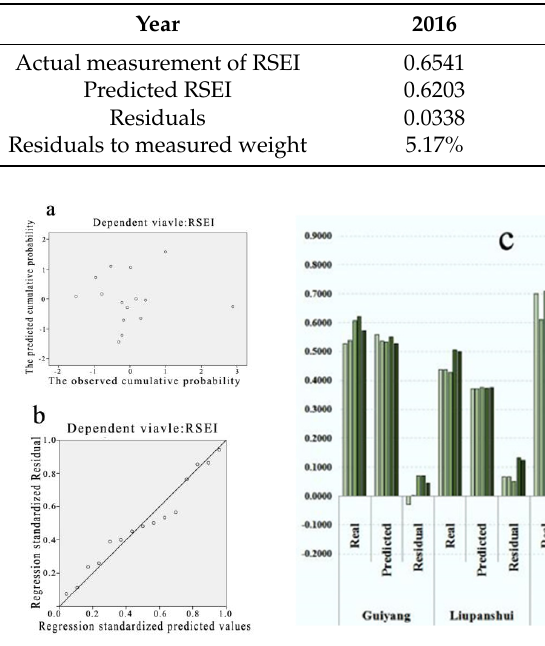
Figure 9. ( a ) The P–P plot of regression standardized residuals; ( b ) Residual scatter diagram. Note that ( a , b ) indicate that this linear regression fit fully satisfied the conditions of use; ( c ) Implementation period residual results distribution